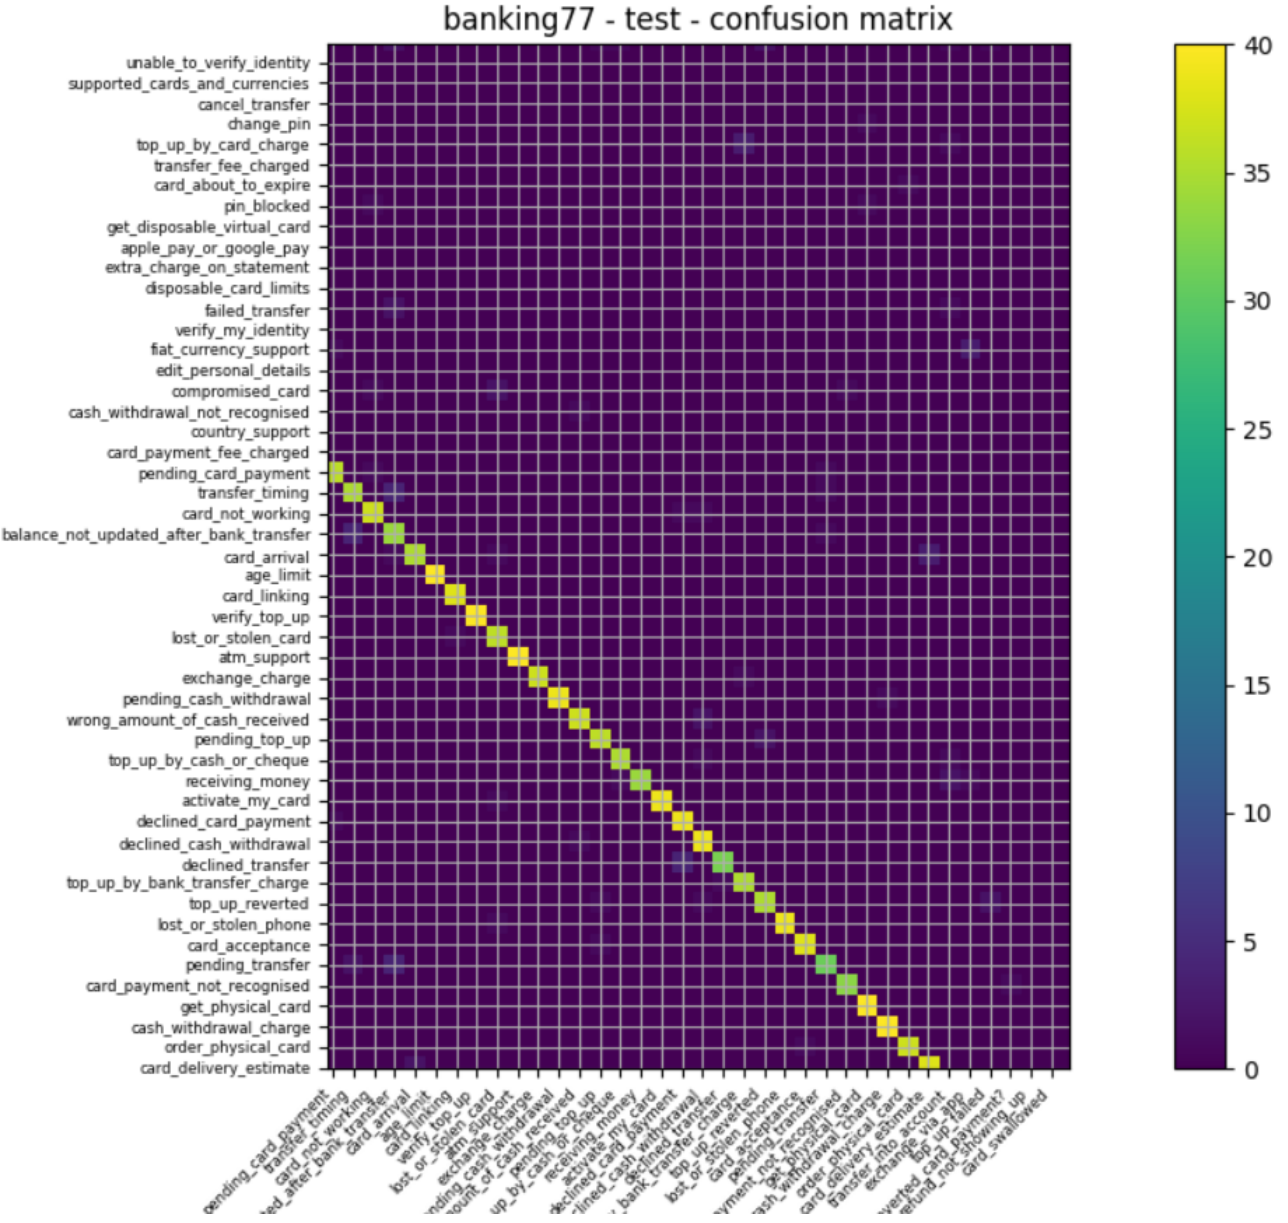
Figure 1. Selected section of the confusion matrix obtained for classifying BANKING77 test instances, with a model using the ConveRT language model featurizer. The yellow-green hue represents correctly classified test instances and it represents the main diagonal of the full